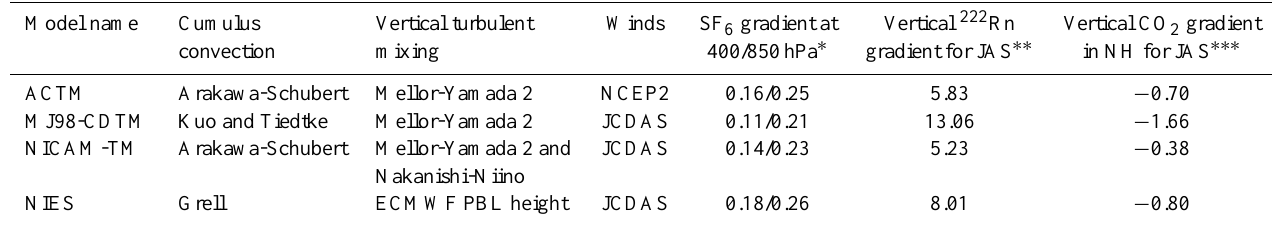
Table 2. List of the transport models, and their fundamental